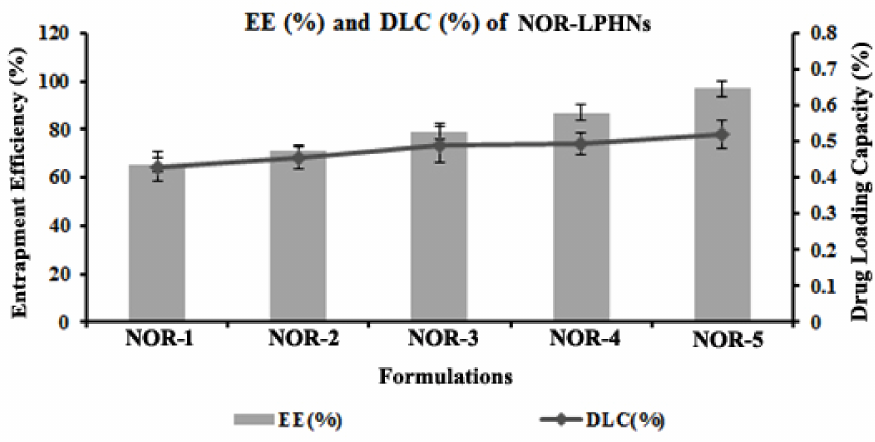
Figure 2. EE and DLC of the prepared formulations.